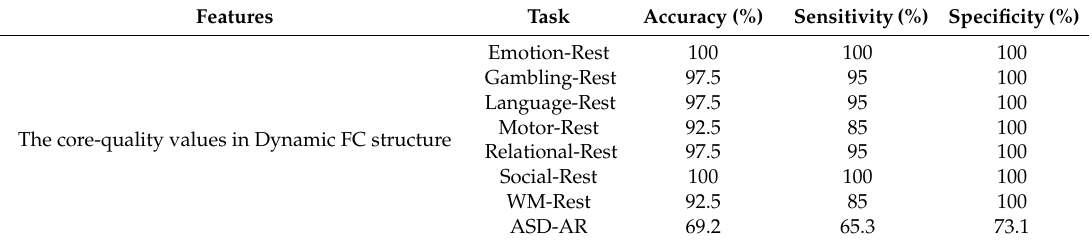
Table 2. The eight linear SVM classifiers’ accuracy with a leave-one-out cross-validation strategy for the seven tasks and the resting state, the ASD and AR resting states with the naive dFC structure. Sensitivity accuracy is the accuracy of emotion, gambling, language, motor, relational, social, and WM tasks and the ASD resting state. The specificity accuracy is the accuracy of the resting state and AR resting